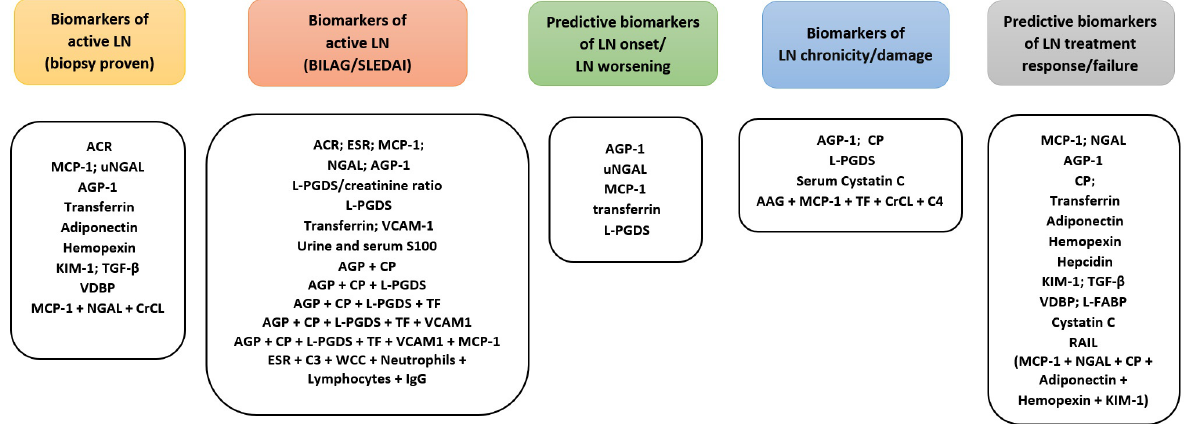
Figure 1. Biomarkers with potential clinical utility in JSLE associated LN. AAG α (1) -acid glycoprotein, AGP-1 Alpha-1-acid Glycoprotein, AGP-1 Alpha-1-acid Glycoprotein, BILAG British Isles Lupus Assessment Group, C4 Complement fraction 4, CP Ceruloplasmin, CrCl creatinine clearance, KIM-1 Kidney Injury Molecule-1, L-FABP Liver-Fatty Acid Binding Protein, LN lupus nephritis, L-PGDS Lipocalin-type Prostaglandin-D Synthetase, MCP-1 Monocyte Chemoattractant Protein-1, uNGAL urinary Neutrophil Gelatinase Associated Lipocalin, RAIL Renal Activity Index in Lupus, SLEDAI Systemic Lupus Erythematosus Disease Activity Index, TGF β Transforming Growth Factor β , TF transferrin, u urinary, VCAM-1 Vascular cell adhesion protein 1, VDBP Vitamin-D Binding Protein, WCC white cell count.